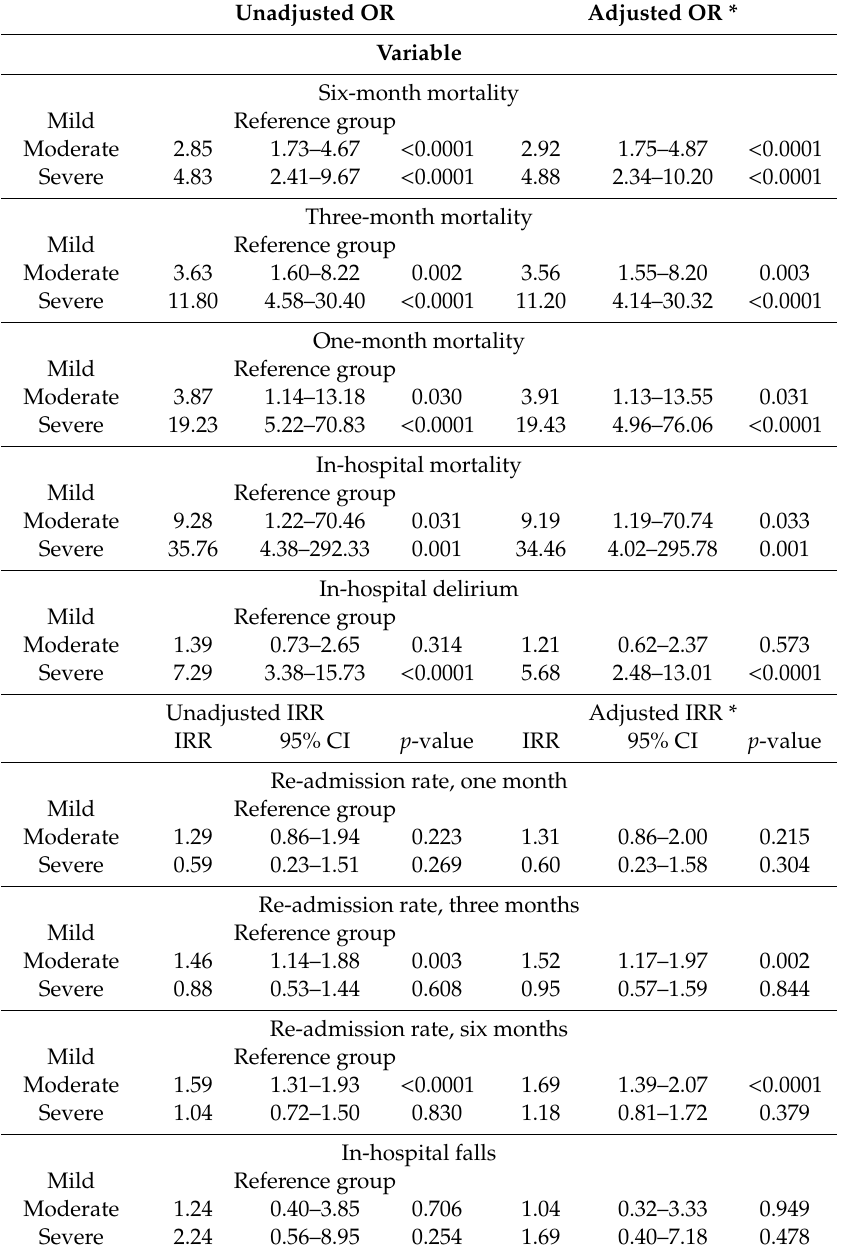
Table 2. FMC cohort and secondary outcomes for MPI risk